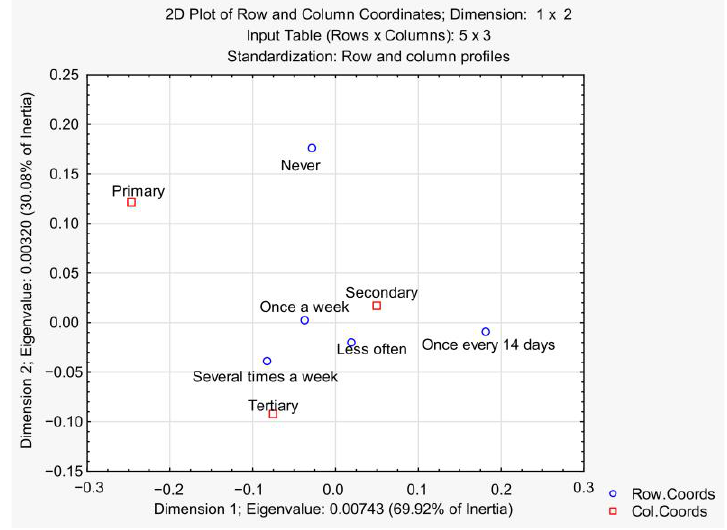
Figure 7. Correspondence maps, Supermarkets & Respondent’s education. Source: authors.